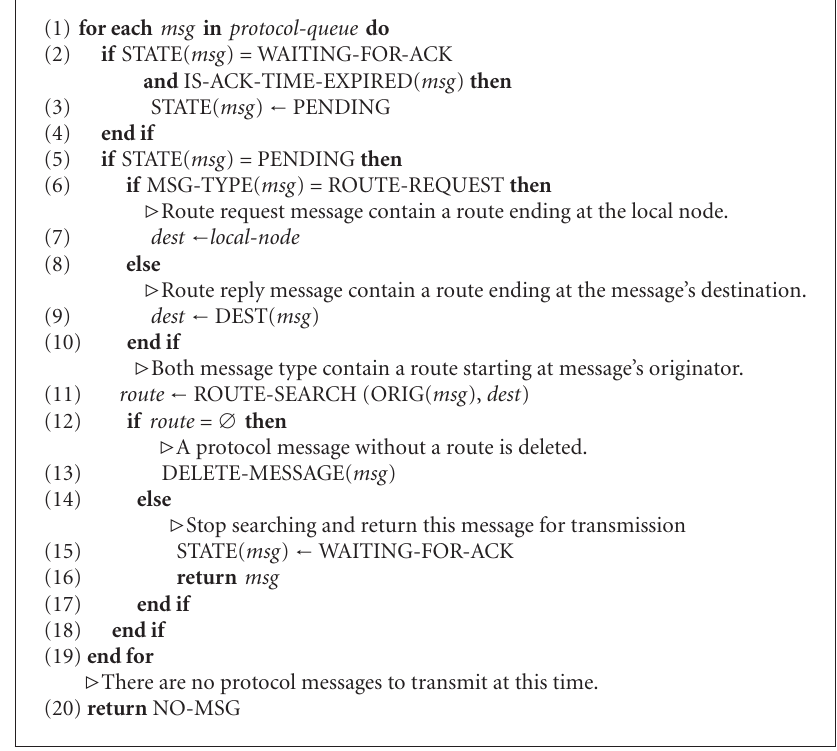
Algorithm 2: The algorithm for obtaining the next user-data message from the data